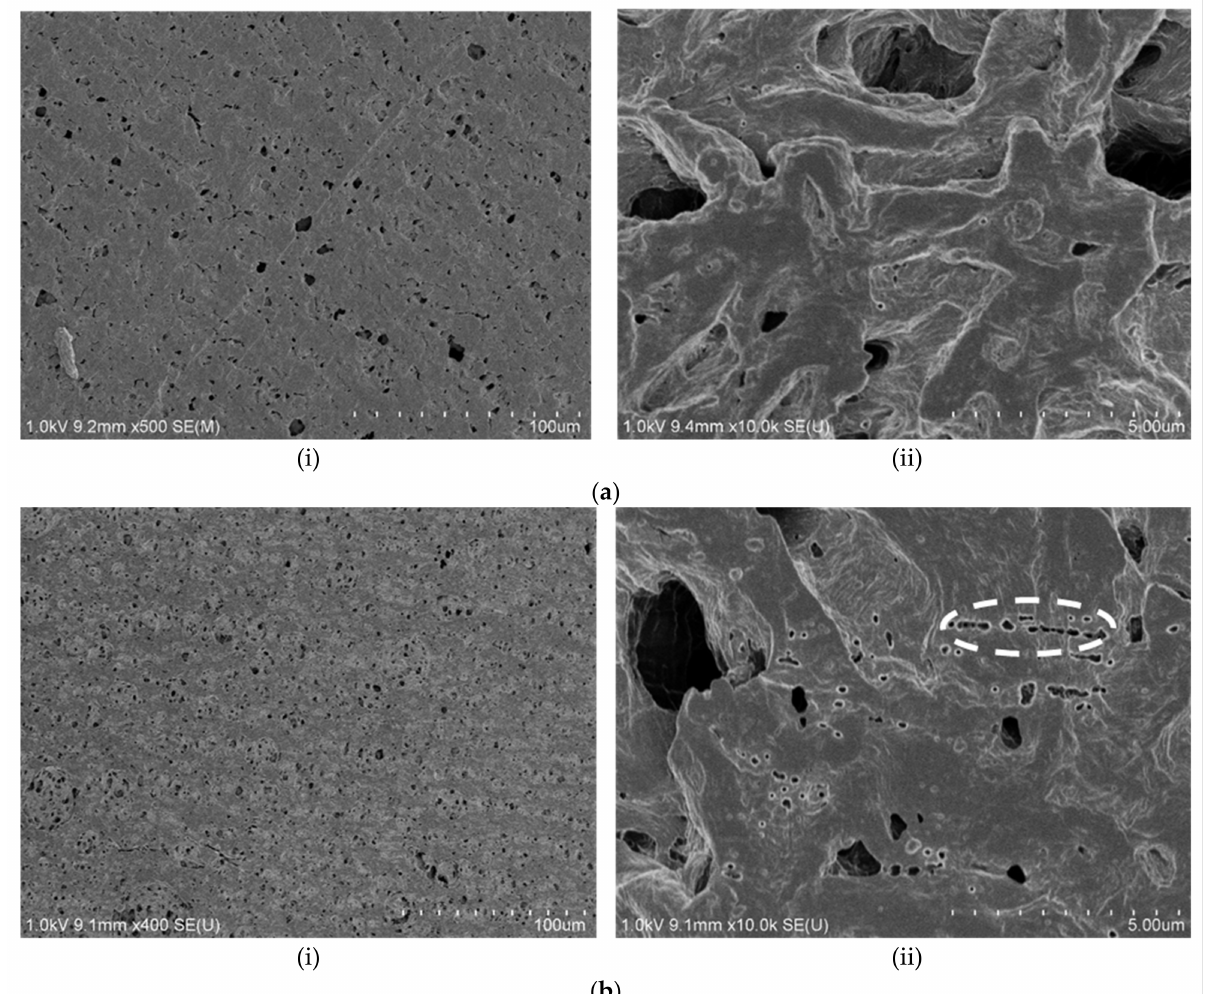
Figure 6. SEM morphology images of ( a ) non-crazed PLA/PAni film (i) 500 × and (ii) 10,000 × ; ( b ) crazed PLA/PAni film (i) 400 × and (ii) 10,000 ×